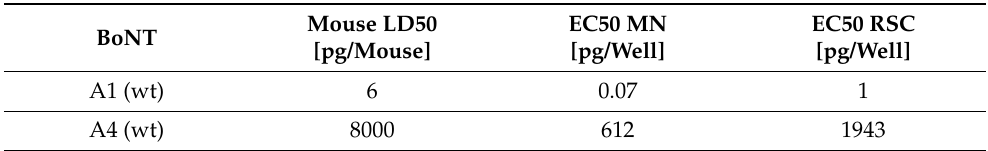
Table 1. Potency of BoNT/A1 and BoNT/A4 in mice and human motor neurons and rat spinal cord cells. Mouse LD50 EC50 MN EC50 RSC BoNT [pg/Mouse] [pg/Well] [pg/Well] A1 (wt) 6 0.07 1 A4 (wt) 8000 612